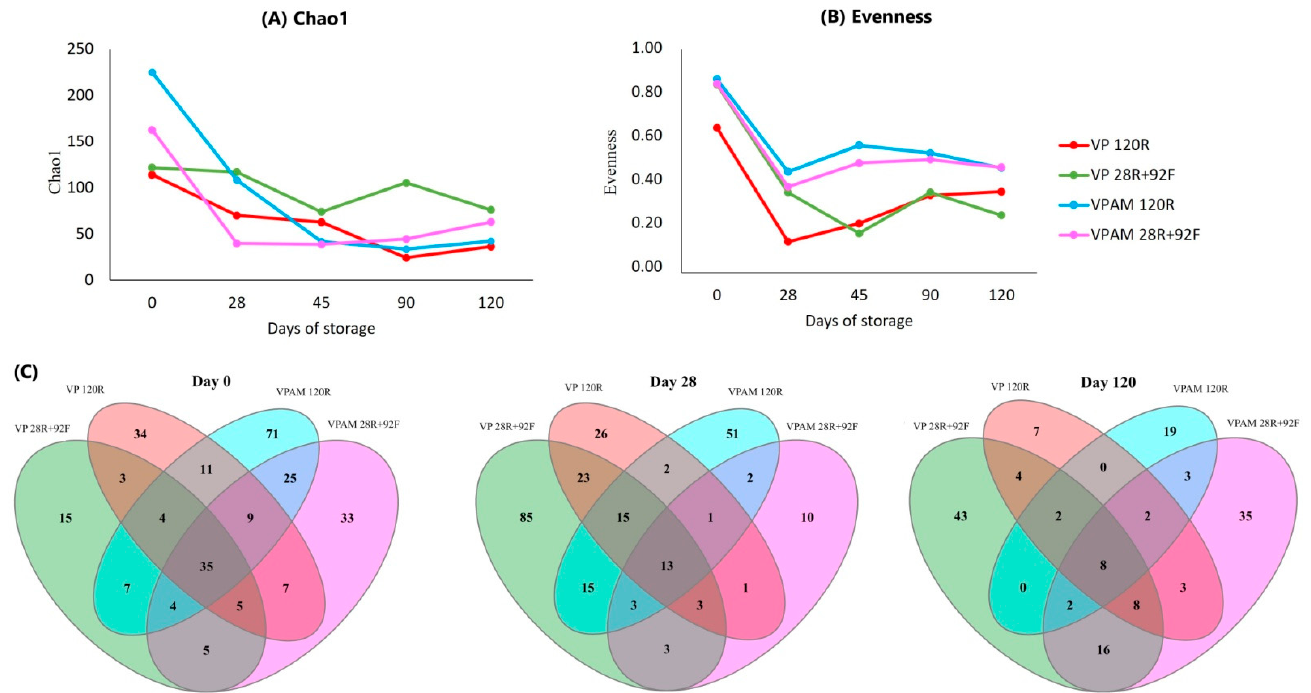
Figure 3. Chao 1 ( A ) and evenness ( B ) alpha diversity of the bacterial microbiome of meat samples at amplicon sequence variant level (ASV). Venn diagram ( C ) showing the unique and shared genera between treatments on day 0, 28, and 120 of storage. Treatments: vacuum packaging for 120 days (refrigerated) (VP 120R), vacuum packaging for 28 days (refrigerated) + 92 days (frozen) (VP 28R+92F), vacuum packaging with antimicrobial for 120 days (refrigerated) (VPAM 120R), vacuum packaging with antimicrobial for 28 days (refrigerated) + 92 days (frozen) (VPAM 28R+92F).